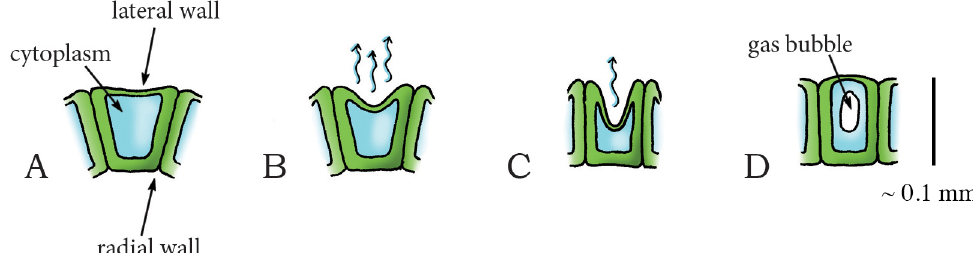
Fig 19. Cavitation in plant cells. A regular plant cell consisting of a cell wall and cytoplasm. (B) Evaporation of water from the cell causes the radial walls to come closer together and the lateral wall to cave inwards. (C) The lateral wall is caved inwards completely. (D) When a critical pressure is reached, the cytoplasm fractures and a gas (cavitation) bubble appears, causing the walls to rapidly snap back to their original form. Drawings based on figures in [95]. Scale bar 0.1 mm (100 μ